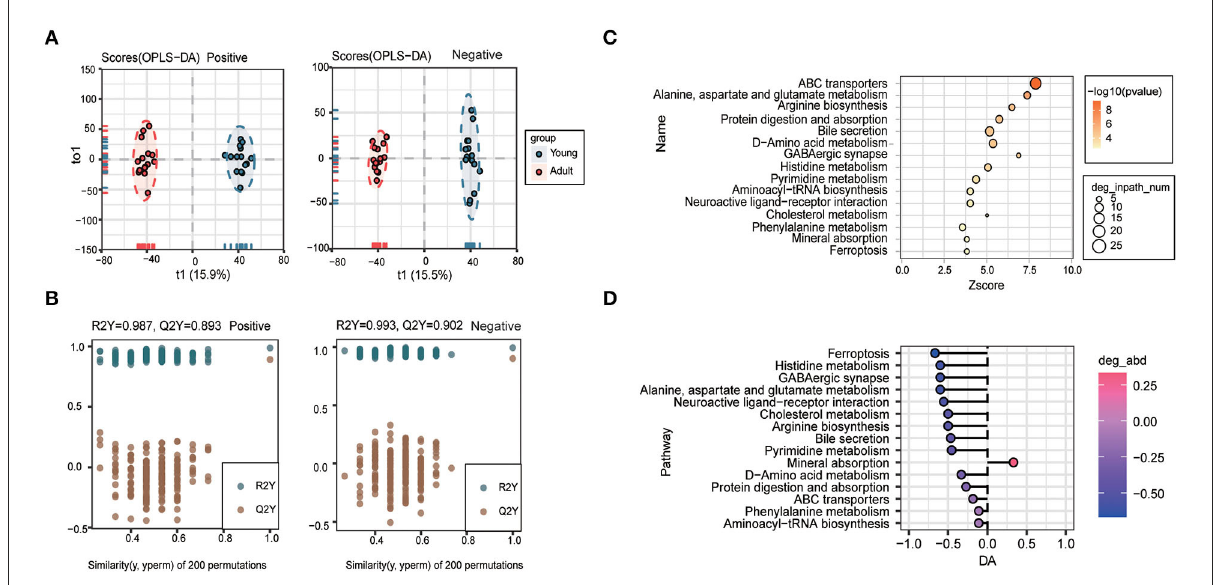
FIGURE3 Plasma metabolomics profiles were largely remodeled during canine growth. (A, B) Orthogonal partial least squares discriminant analysis (OPLS-DA) score plot (A) and validation plot of the OPLS-DA model (B) of the young group and the adult group in positive (left) and negative (right) ion modes. (C, D) Pathway analysis for plasma differential metabolites between young and adult groups was performed based on the Kyoto Encyclopedia of Genes and Genomes (KEGG) pathway enrichment analysis. The 15 most significantly enriched pathways (C) and differential abundance (DA) score of these pathways (D)